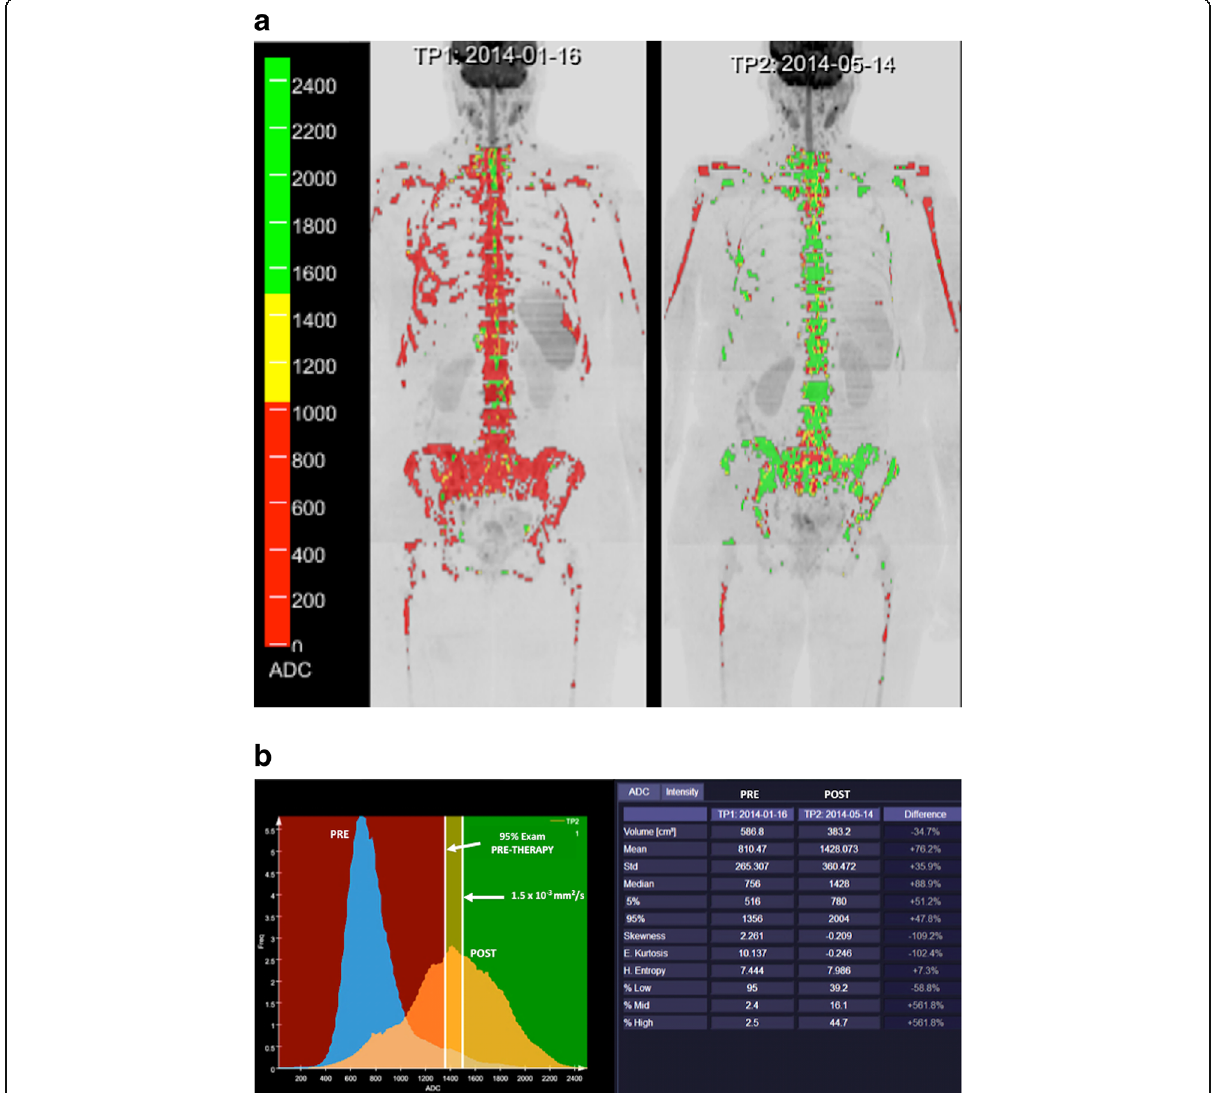
Fig. 6 A 52-year-old woman with metastatic breast cancer treated with chemotherapy ( a ). Whole body diffusion-weighted inverted gray-scale maximun intensity projection (MIP) of b = 900 s/mm 2 images superimposing the ADC values associated with each voxel in color scale before (left) and after one cycle of therapy (right). Red colored voxels represent untreated disease or those with no-detectable response. Thus, yellow voxels represent regions “ likely ” to be responding. Green colored voxels have ADC values ≥ 1500 μ m 2 /s representing voxels that are “ highly likely ” to be responding with tumor cell kill. Tumor evaluation showed a great change in ADC values (predominantly green voxels with ADC values ≥ 1500 μ m 2 /s) indicating tumor necrosis. b A detailed ADC analysis of histogram metrics evidenced a reduced tumor volume as well as improvement in several histogram metrics (mean ADC, kurtosis, etc.) that have changed significantly during treatment due to extensive necrosis (compare to Fig.